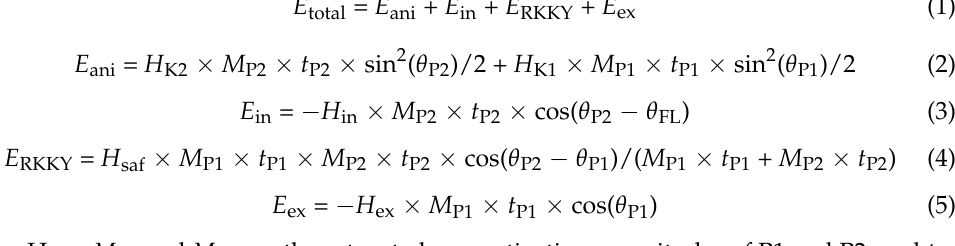
Figure 6. ( a ) Magnetization loops (black line) and Rs-H loops (red line) of the film with t NiFeCr = 8.2 nm; ( b ) magnetization evolutions of P1 and P2 under different annealing processes. In the case of the zero-field cooling process, as the annealing temperature is near the blocking temperature of IrMn, the exchange coupling field H ex generated at the IrMn/CoFe interface is small. H ex is also related to the level of ordering of IrMn induced by the seed layer [29]. The interlayer coupling effect between the P2 and FL layers is ferromagnetic, which is mainly caused by the orange peel coupling from surface roughness. Because the total magnetization of P2 and FL is greater than that of P1, the P2 magnetization direction always tends to align with the annealing field direction. The P1 magnetization direction should be antiparallel to that of P2 due to the RKKY antiferromagnetic coupling. Meanwhile, the exchange coupling from the IrMn layer forces the magnetization direction of the P1 layer to go along with the annealing field direction. Therefore, in the film with a wedge-shaped seed layer, when the seed layer thickness exceeds a critical value, the exchange coupling effect dominates and the pinning direction is along the + x axis. The final state of the pinning direction may be along the + x ( − x ) direction when the exchange coupling effect is stronger (weaker) than that of the interlayer coupling effect.